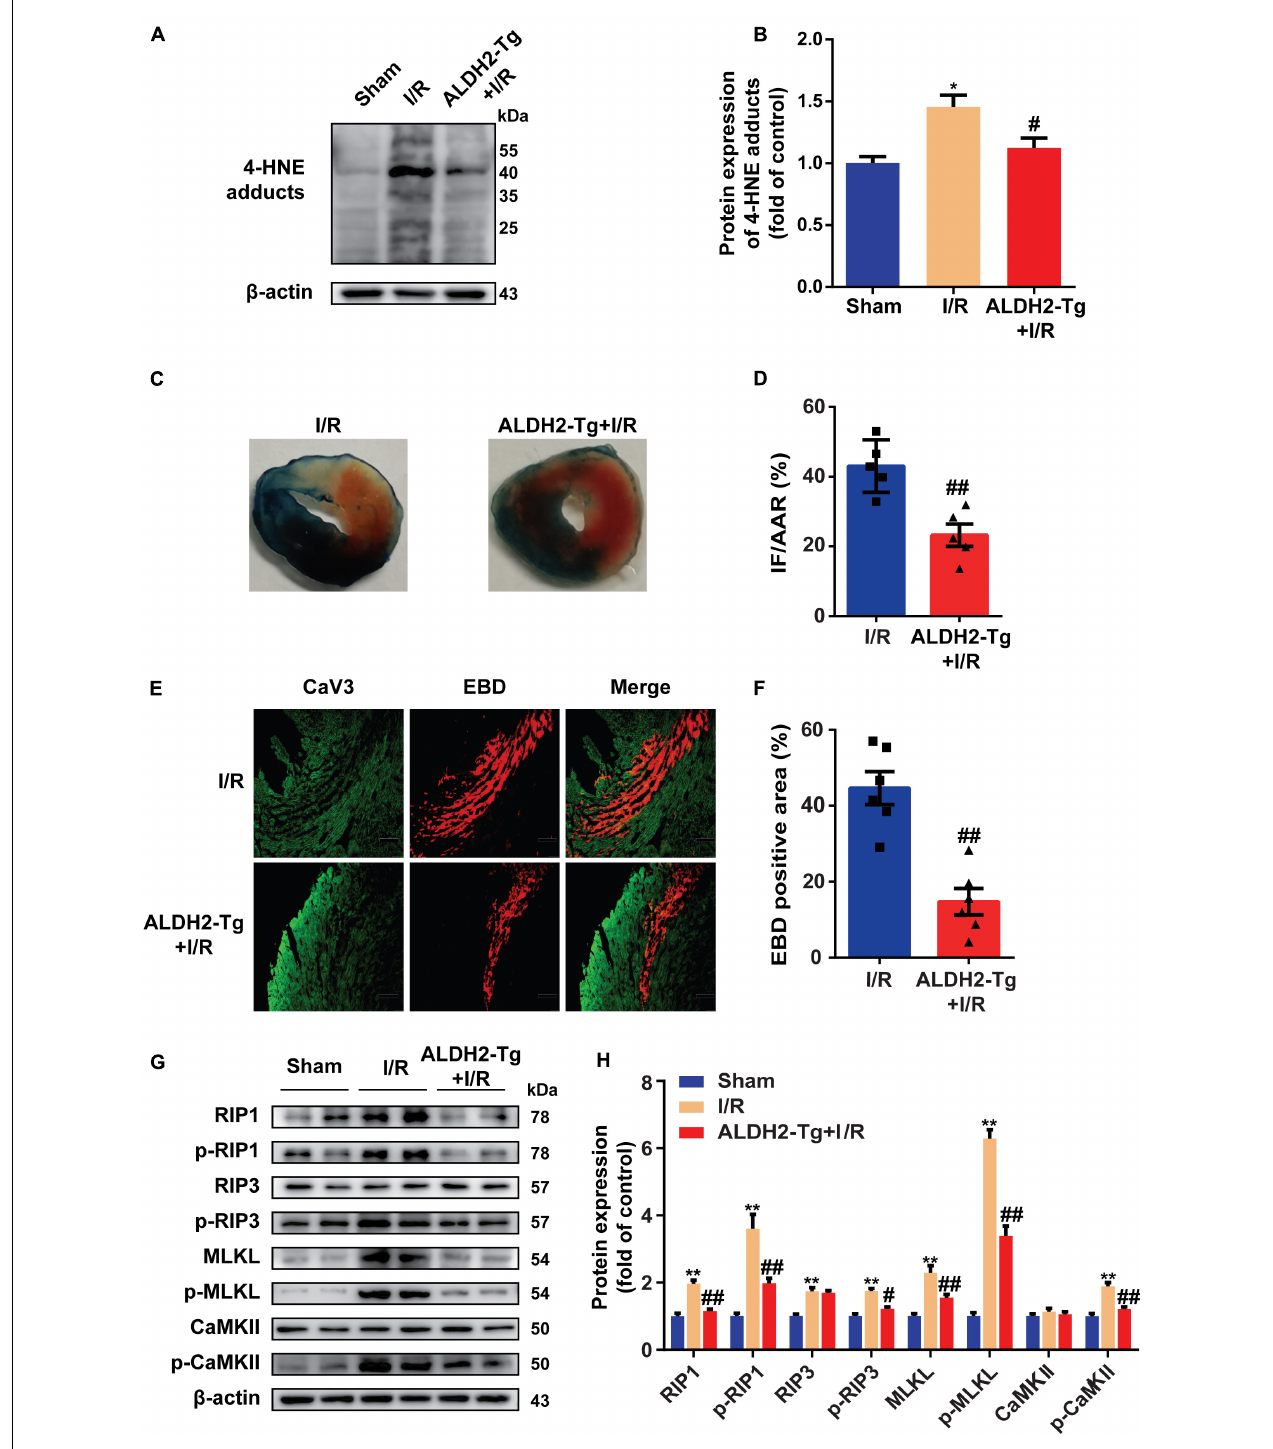
FIGURE 2 | Detoxifying 4-hydroxy-2-non-enal protects against myocardial ischemia/reperfusion (MI/R) injury by reducing necroptosis. (A,B) Representative Western blots and relative expression of 4-HNE adducts in mouse hearts ( n = 5). (C,D) Representative sections and statistical analysis of mouse hearts stained with Evans blue dye (EBD)/2,3,5-triphenyl tetrazolium chloride (TTC). White area stands for infarction area (IF); white and red area stands for area at risk (AAR) ( n = 5). (E,F) Representative sections and analysis of heart sections stained with EBD and CaV3 ( n = 6). Scale bar = 100 µ m. (G,H) Representative immunoblots and relative expression of receptor-interacting serine/threonine-protein kinase 1 (RIP1), p-RIP1, RIP3, p-RIP3, mixed lineage kinase domain-like pseudokinase (MLKL), p-MLKL, Ca 2 + /CaMKII, and p-CaMKII in mouse hearts ( n = 6). * p < 0.05 vs. sham group, ** p < 0.01 vs. sham group; # p < 0.05 vs. I/R group, ## p < 0.01 vs. I/R group.